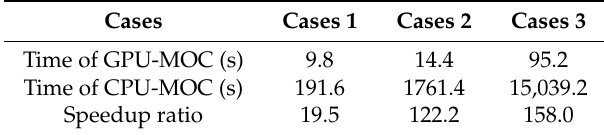
Table 3. Consumed time and speedup ratios of the two methods. Table 2. Consumed time and speedup ratios of the two methods. Table 2. Consumed time and speedup ratios of the two methods.